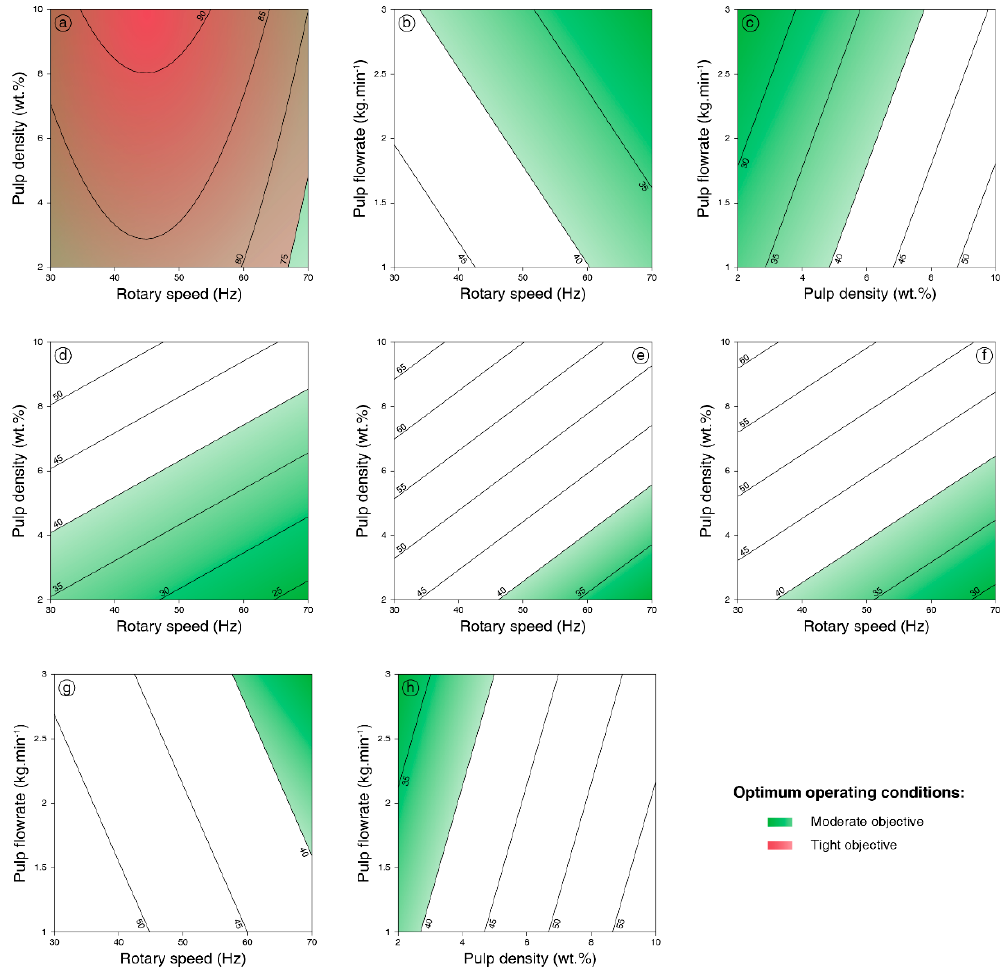
Figure 3 . 2-D contour plots for WO 3 recovery ( a ), K 2 O recovery ( b – d ), P 2 O 5 recovery ( e ), and Fe 2 O 3 recovery ( f – h ) for the Falcon UF models as a function of the operating parameters. The colored zones correspond to values that satisfy the performance objectives defined in Table 3.